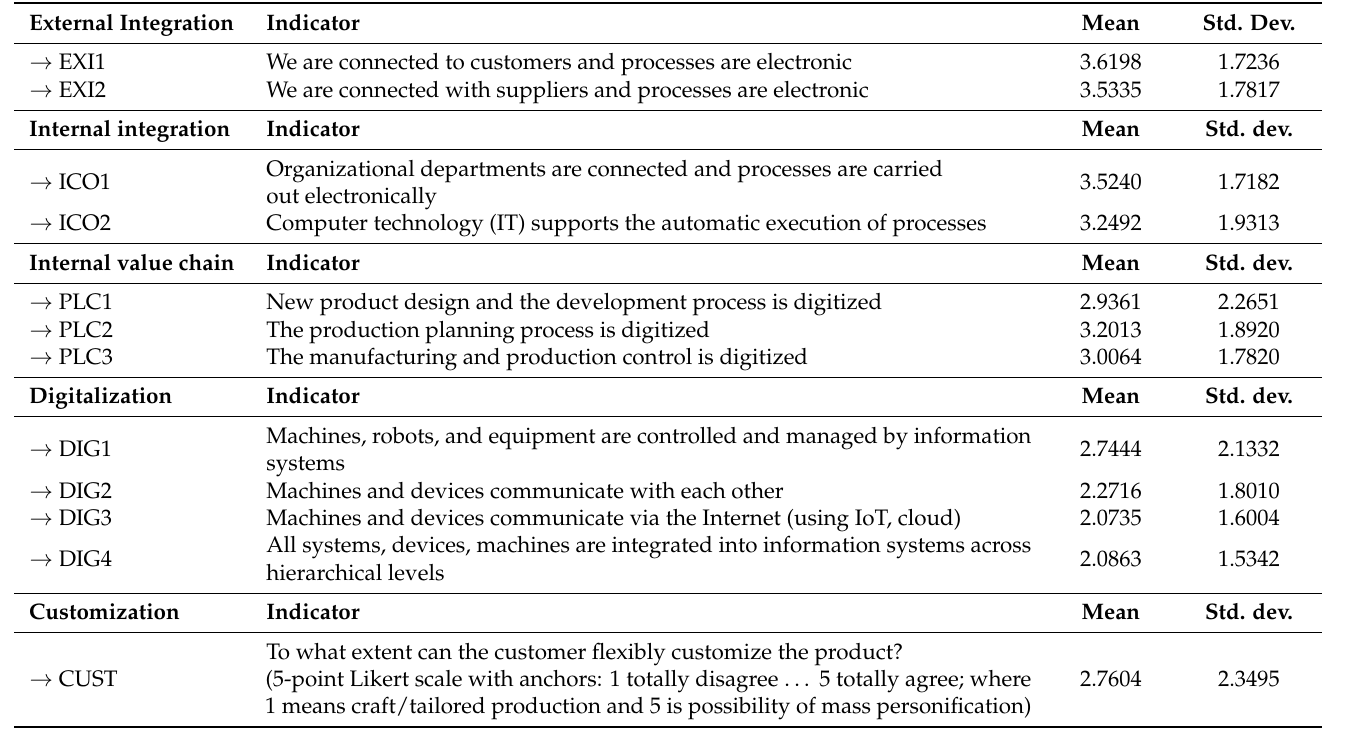
Table A2. The measurement items and indicators.